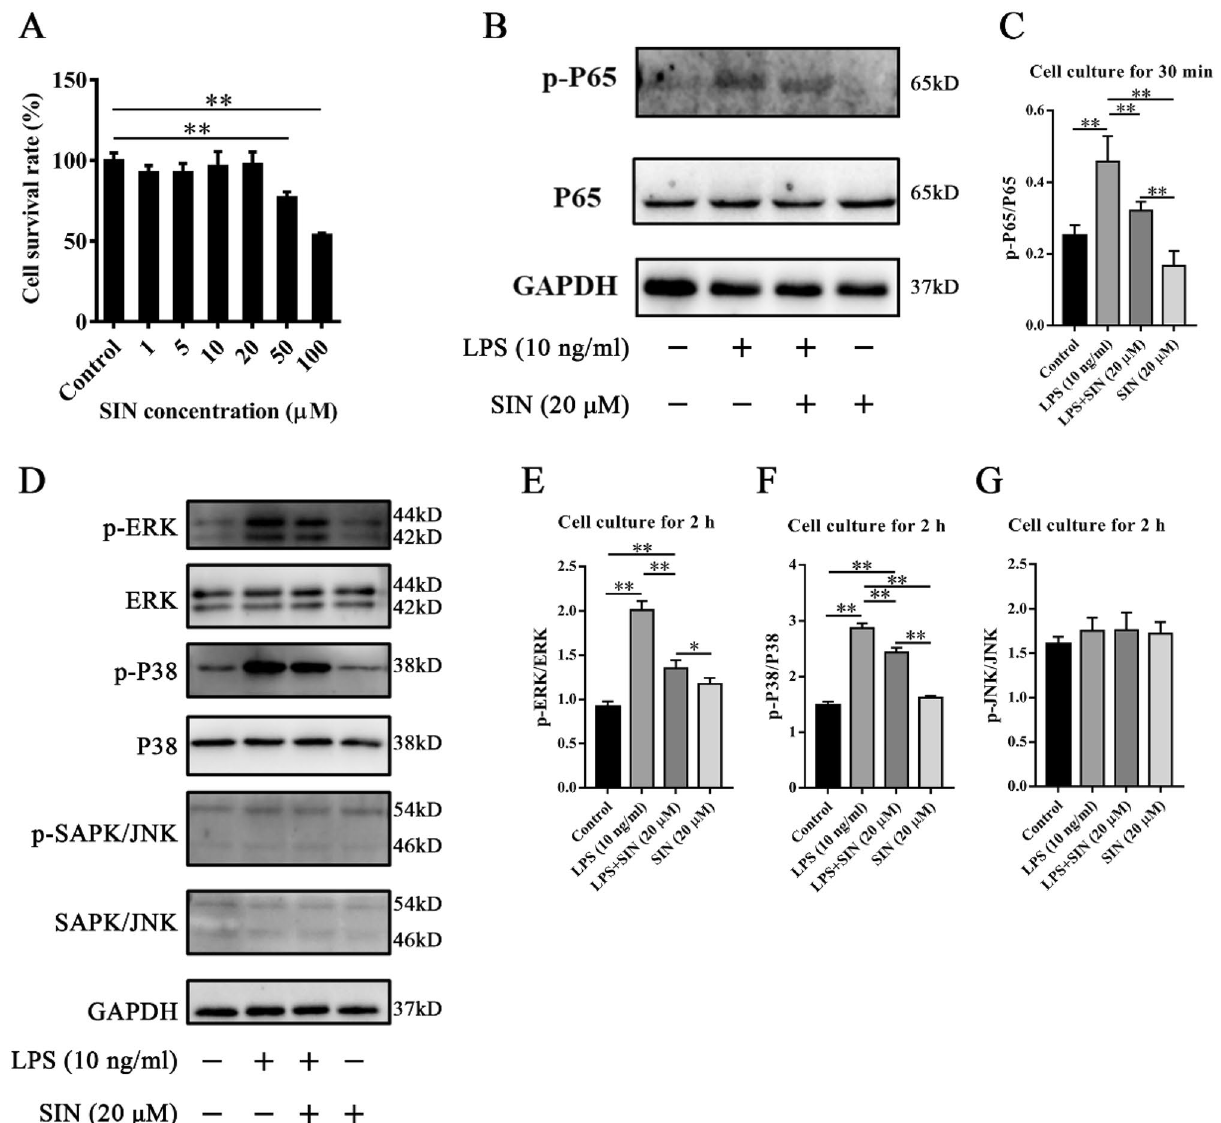
Figure 4. Sinomenine inhibited the inflammatory activity of neutrophils in vitro. ( A ) The effect of Sinomenine on the activity of neutrophils. CCK-8 assays were used to detect the effect of Sinomenine on neutrophil activity after four hours of culture. Statistical analysis was applied to calculate the cell survival rate of each group. The data are expressed as the mean ± SD (n = 6). ( B ) Western blot analysis of the levels of p-P65 and P65 in neutrophils of each group with different treatments. GAPDH was used as an internal control. Representative images are shown (working concentration of p-P65 and P65 antibodies: 1:1000). ( C ) The relative levels of p-P65/P65 in (B). The data are shown as the mean ± SD (n = 3). ( D ) Western blot analysis of the levels of p-ERK, ERK, p-P38, P38, p-JNK and JNK. GAPDH was used as an internal control. Representative images are shown (working concentration of p-ERK, ERK, p-P38, P38, p-JNK and JNK antibodies: 1:1000). ( E ) The relative levels of p-ERK/ERK in (D). The data are shown as the mean ± SD (n = 3). ( F ) The relative levels of p-P38/P38 in (D). The data are shown as the mean ± SD (n = 3). ( G ) The relative levels of p-JNK/JNK in ( D ). The data are shown as the mean ± SD (n = 3). *p < 0.05 , **p < Sinomenine downregulated the expression of Beclin-1 and suppressed the conversion from microtubule-associ- ated protein 1 light chain 3-I (LC3-I) to LC3-phosphatidylethanolamine family protein conjugation (LC3-II) in PMA-induced neutrophils (Fig. 8E–G). These results showed that Sinomenine significantly inhibited neutrophil autophagy.